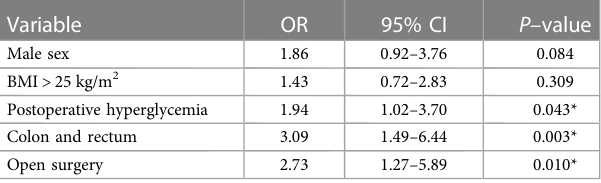
TABLE 3 Multivariate logistic regression analysis of the risk factors for incisional